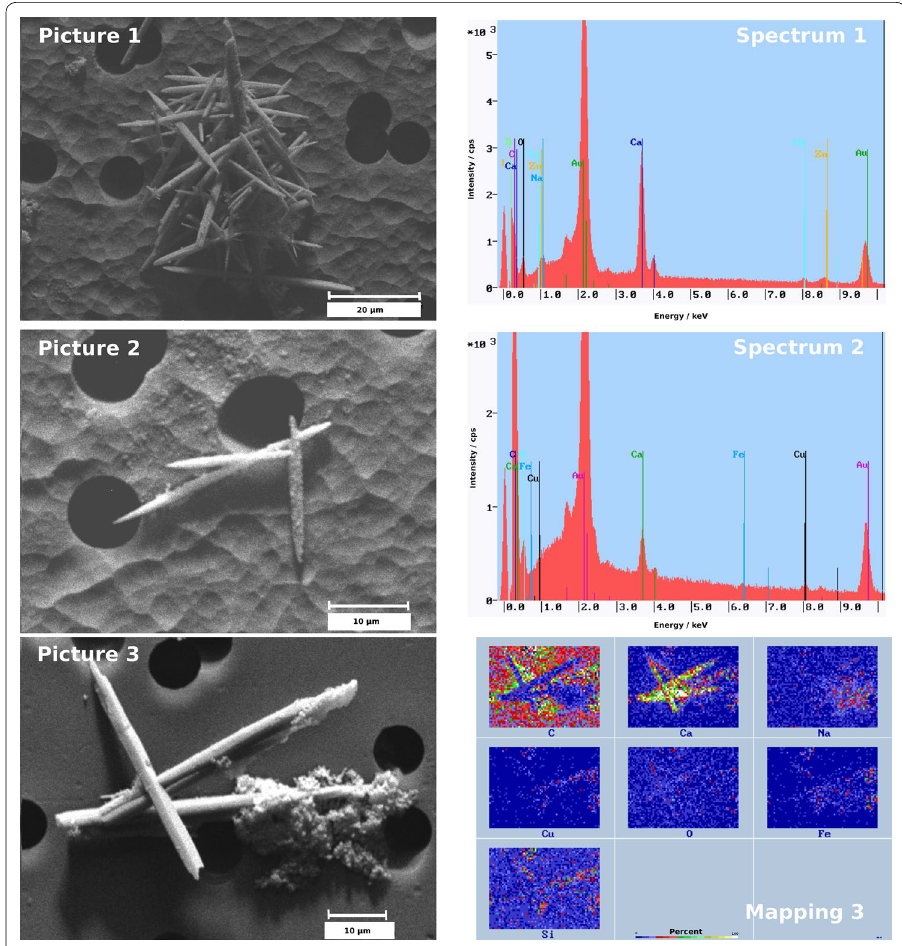
Fig. 11 Typical carbonate crystals during T Inj = 110 ◦ C : SEM picture (left) and corresponding EDX spectrum resp. mapping (right). Examples for injection (Picture 2) and production at 37 ◦ C (Picture 1) 60 ◦ C (Picture 3). All pictures at these injection temperatures show acicular aragonite